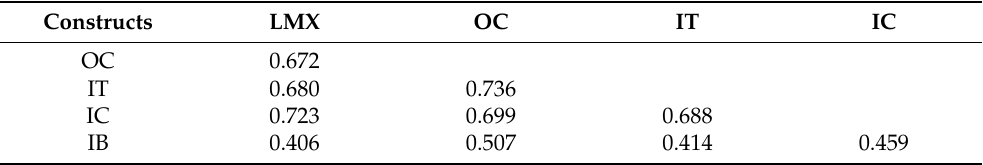
Table 4. Heterotrait–monotrait (HTMT) ratios.